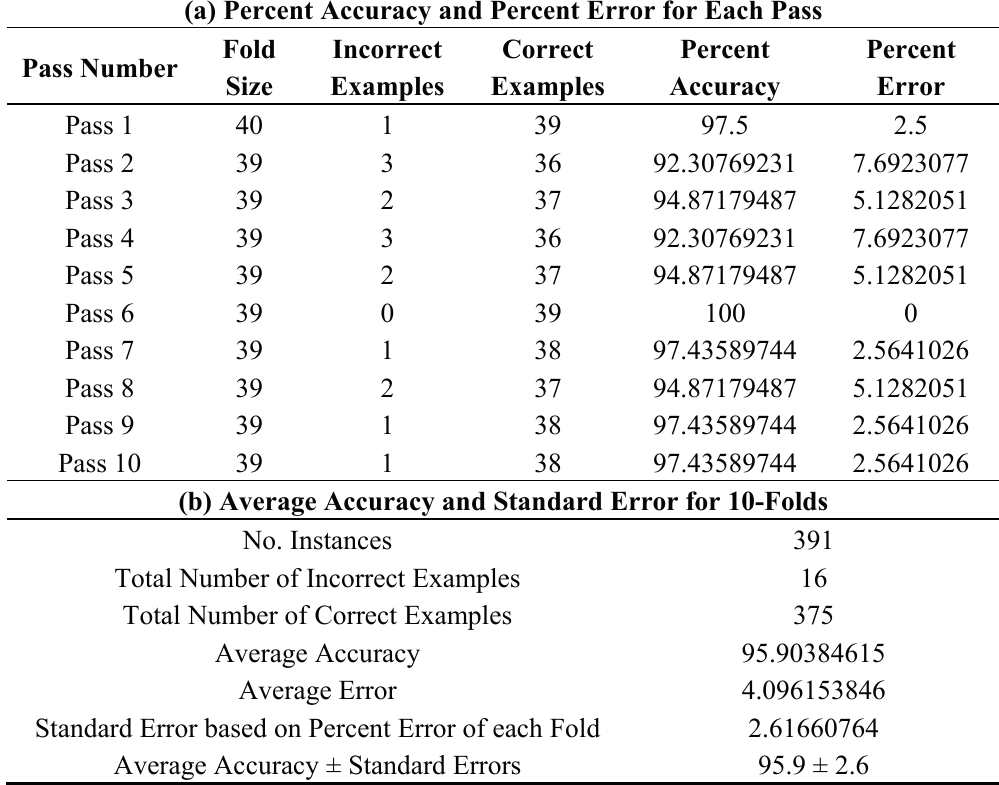
Table 12. Percent accuracy and percent error for each test of the 10-fold cross validation process along with average accuracy and standard error of all 10-folds